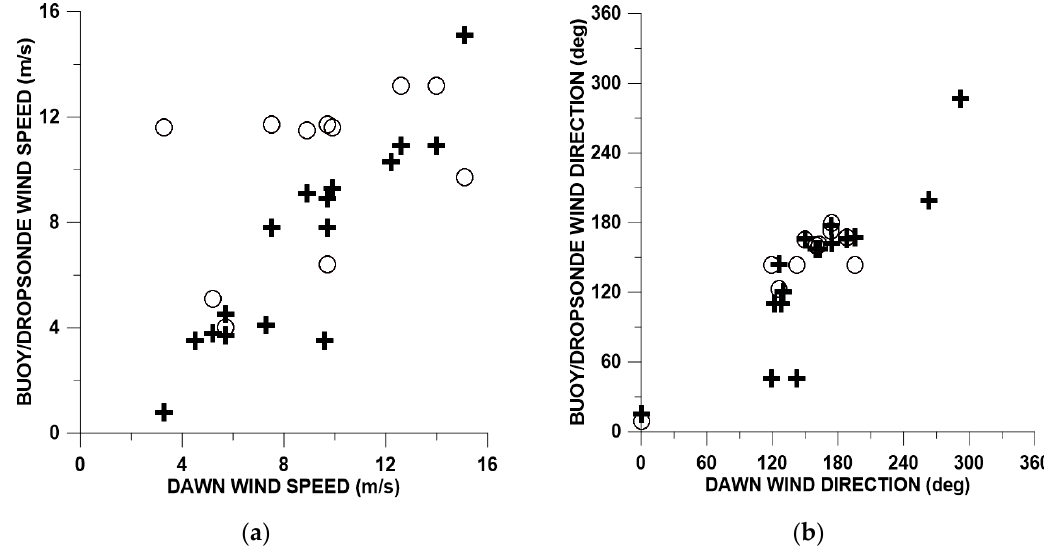
Figure 12. Scatterplots of the DAWN-buoy ( + ) and DAWN-dropsonde ( ○ ) comparisons for wind speed ( a ) and wind direction ( b ) during CPEX missions flying over or near NDBC buoys.